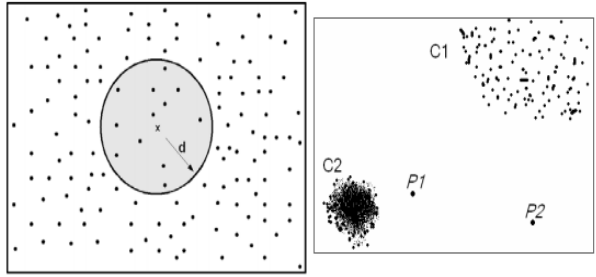
Figure 1: Difference between distance-based approach (LEFT) and Density-based approach